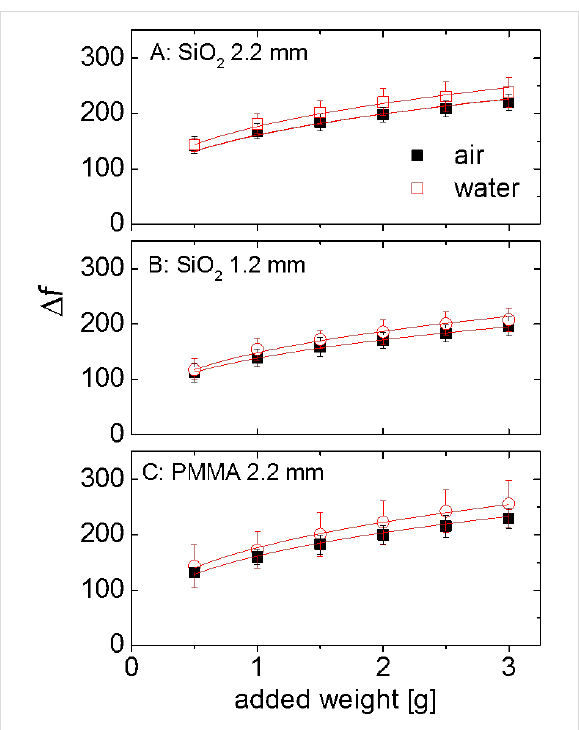
Figure 5: Frequency shifts in the low-amplitude limit obtained on silica surfaces (A and B) and on a PMMA surface (C). All data shown are averages from 9 experiments. Error bars are standard deviations. Dotted lines show JKR fits with parameters as given in Table 1.